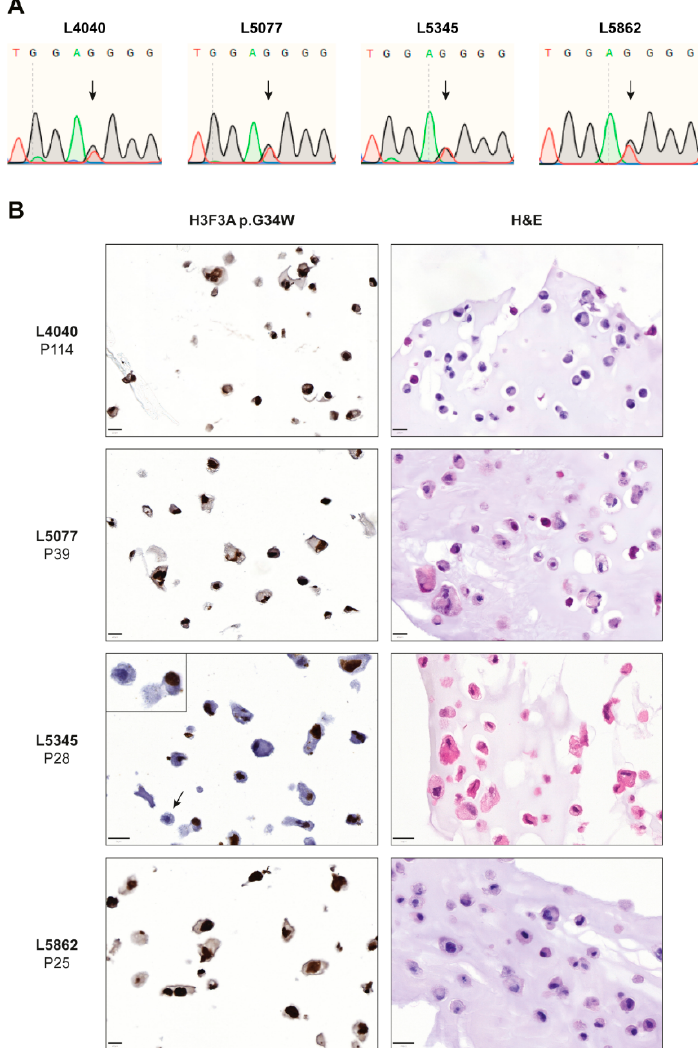
Figure 1. Established cell lines consist of neoplastic “stromal” cells that express the H3F3A p.G34W oncohistone in vitro. ( A ) Sanger sequencing confirmed the presence of the H3F3A p.G34W variant in all established cell lines. ( B ) H&E and H3F3A p.G34W immunohistochemical stains on paraffin- embedded cells of the four established cell lines. All cell lines showed expression of the H3F3A p.G34W mutation in culture. The L5345 cell line contained a small number of negative cells (indicated by arrow and inset). Scale bar: 20 µ